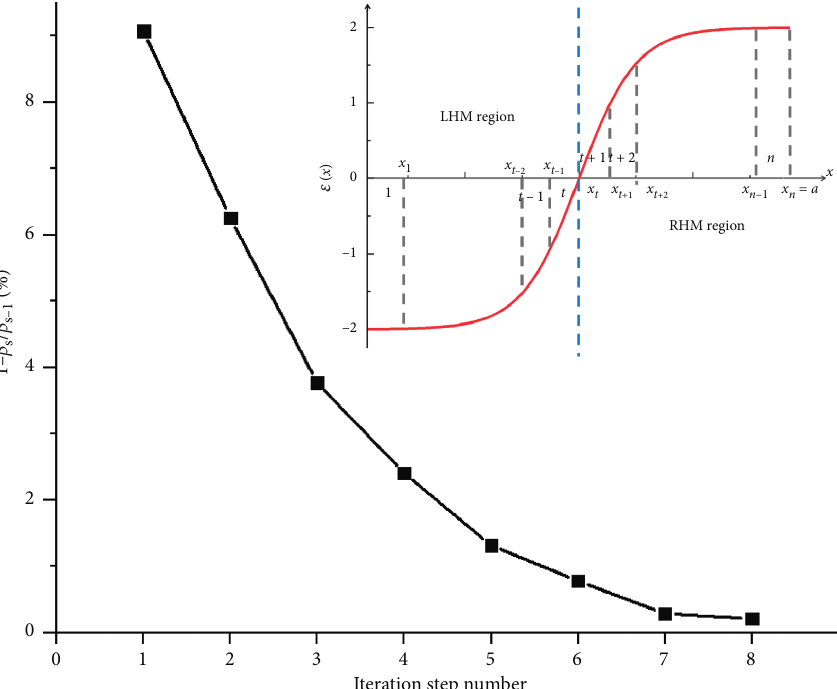
Figure 9: Convergence analysis conducted by HFSS and the inset presents the treatment of the discretization of the graded-index metamaterials.